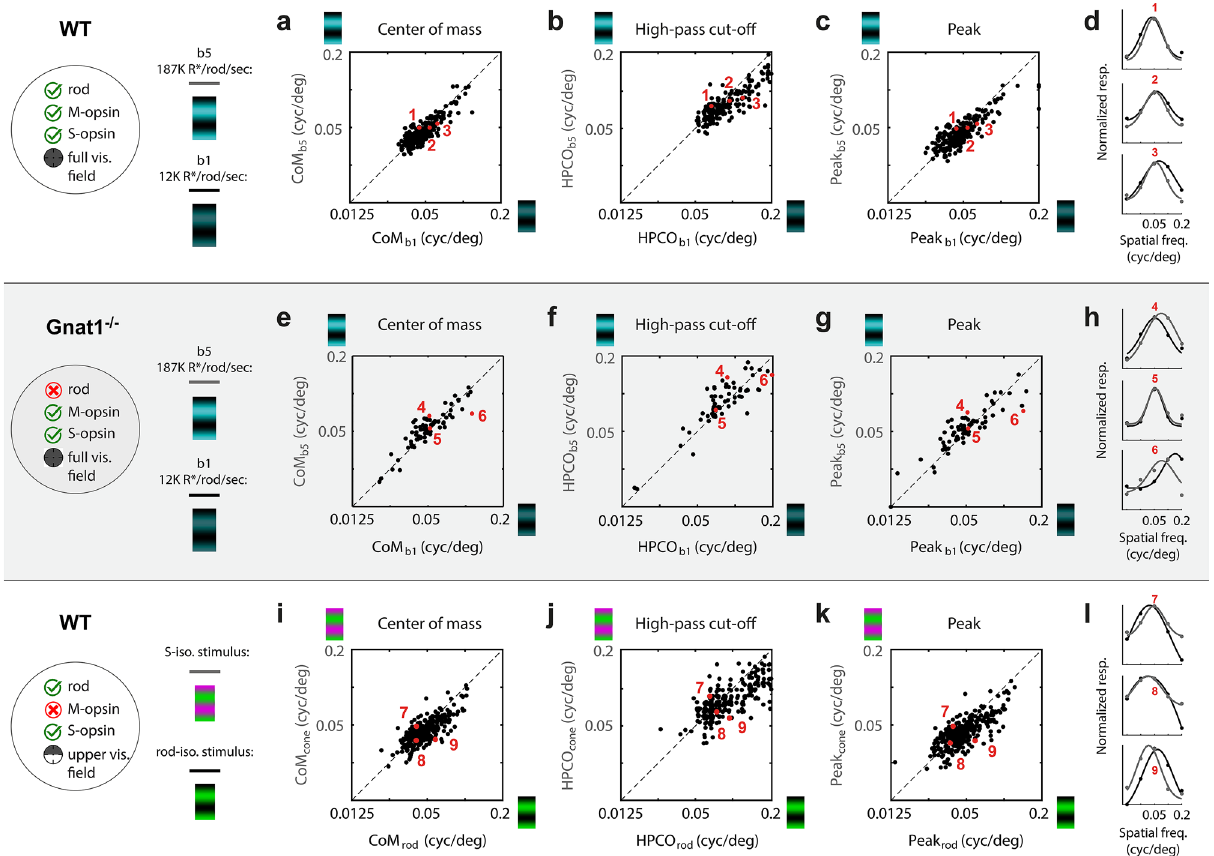
Figure 6. Rod-driven responses in V1 have marginally higher spatial frequency tuning than cone-driven responses. Top row (‘a-d’) shows data from WT mice, comparing spatial frequency tuning at two light adaptation levels, “b1” and “b5”, corresponding to 12 K and 187 K R*/rod/sec (n = 250). ( a ) Scatter plot compares center-of-mass (CoM) estimates of spatial frequency tuning curve at b5 (y-axis) and b1 (x-axis). Each data point represents a single neuron. Unity line is dashed black line. The geometric mean of CoM b5 /CoM b1 is 0.96 (t-test: p = 1.04e −6 ). ( b ) Same as in ‘a’ but the spatial frequency tuning parameter is the high-pass cut-off frequency (HPCO). The geometric mean of HPCO b5 /HPCO b1 is 0.90 (t-test: p = 2.40e −17 ). ( c ) Same as in ‘a,b’ but the spatial frequency tuning parameter is the peak spatial frequency (“Peak”). The geometric mean of Peak b5 / Peak b1 is 0.94 (t-test: p = 2.07e −7 ). ( d ) Tuning and fits of 3 example neurons at the 5th, 50th, and 95th percentile of the distribution of HPCO b5 /HPCO b1 . Dots are normalized responses and lines are the fits. In each case, black and gray correspond to ‘b1’ and ‘b5’, respectively. Next, middle row of panels (‘e–h’) is data from rod-deficient Gnat1 −/− mice, using the same experiment and analysis as in the top row (n = 72). ( e ) The geometric mean of CoM b5 /CoM b1 is 1.05 (t-test: p = .013). ( f ) The geometric mean HPCO b5 /HPCO b1 is 1.06 (t-test: p = 0.021). ( g ) The geometric mean of Peak b5 /Peak b1 is 1.06 (t-test: p = .029). ( h ) Tuning and fits of 3 example neurons at the 5th, 50th, and 95th percentile of the distribution of HPCO b5 /HPCO b1 from ‘f’. Bottom row of panels (‘i-l’) shows data from WT mice, limited to neurons with a receptive field 30-deg above the midline where expression is mostly limited to S-opsin and rhodopsin (n = 361). Here, the background light levels were held constant at b4 or b5 and tuning was compared between stimuli of isolating cone- and rod-contrast. ( i ) Scatter plot compares spatial frequency tuning CoM between the rod (x-axis) and cone (y-axis) isolating contrasts. Geometric mean of CoM cone /CoM rod is 1.02 (t-test: p = 3.35e −4 ). ( j ) Same as in ‘i’ but for HPCO. The geometric mean of HPCO cone / HPCO rod is 0.91 (t-test: p = 1.79e −4 ). ( k ) Same as in ‘i’ but for Peak. The geometric mean of Peak cone /Peak rod is 0.93 (t-test: p = 4.69e −3 ). ( l ) Spatial frequency tuning and fits of 3 example neurons at the 5th, 50th, and 95th percentile of the distribution of HPCO cone /HPCO rod